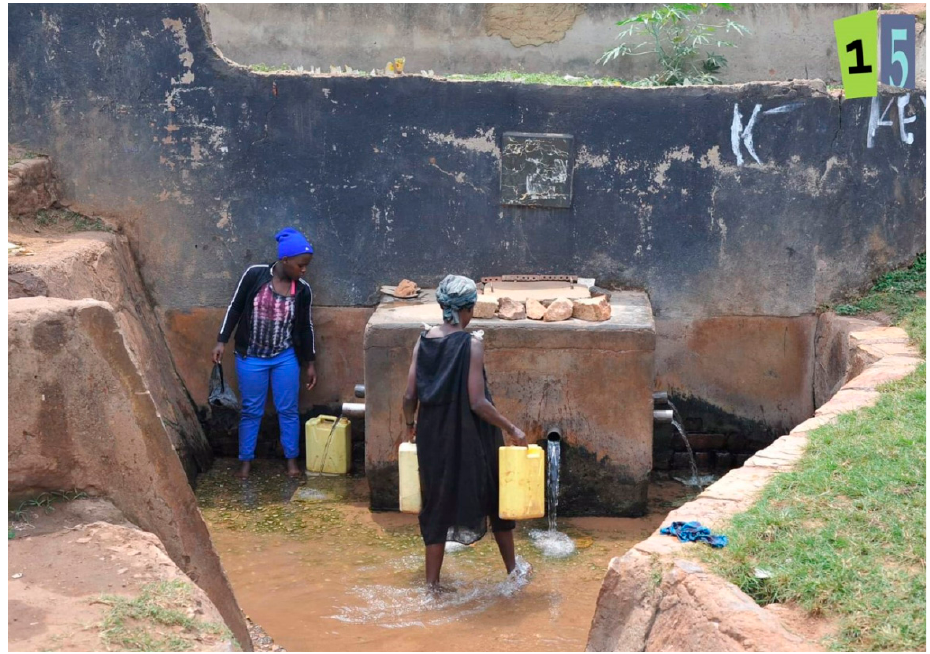
Figure 4. Women Fetching Water in a Well (photo number 15).